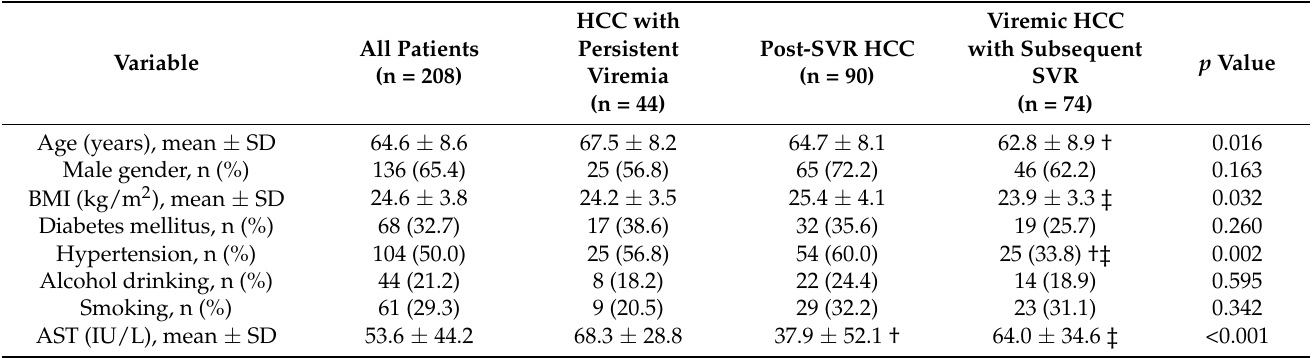
Table 1. Baseline characteristics of the 208 patients with early-stage HCV-related